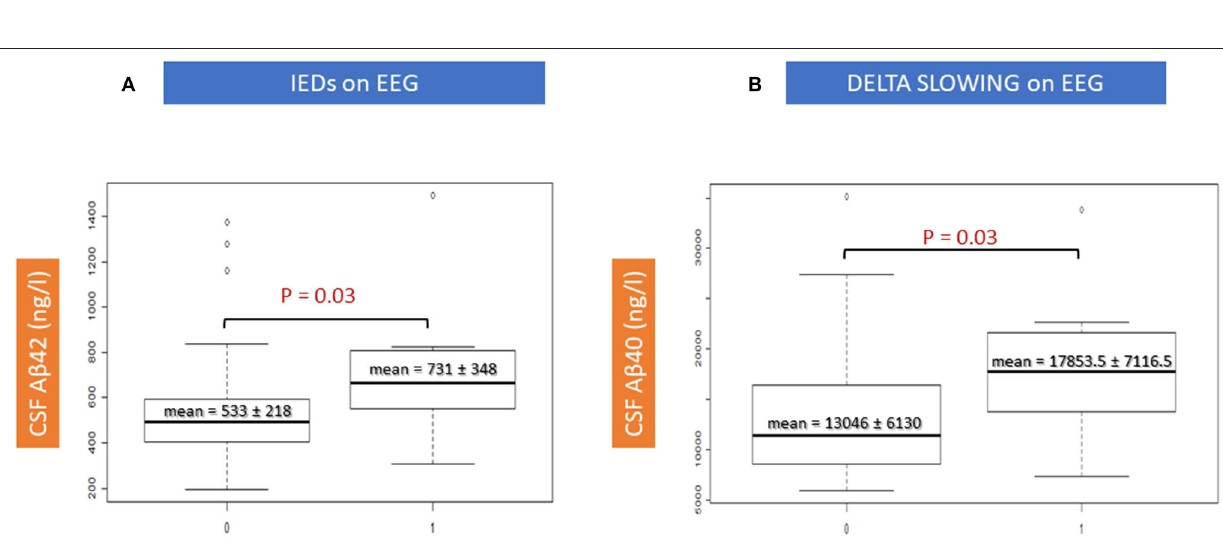
AD-related hyperexcitability and epileptogenesis. The